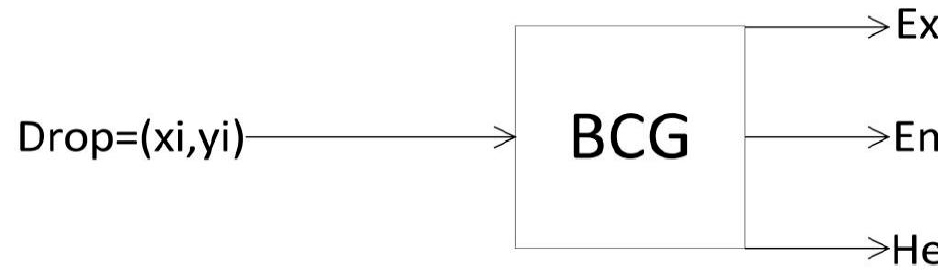
Figure 1. Schematic diagram of reverse cloud